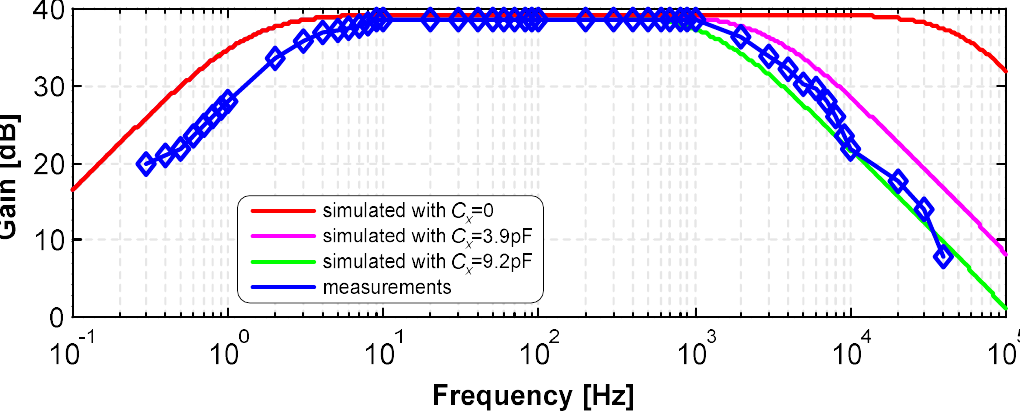
Figure 11. Measured gain and comparison with simulations for C x = 0, C x = 3.9 pF and C x = 9.2 pF. Notice that the upper cutoff frequency of the measured results is smaller than the ideally simulated value (pink plot in Figure 11, where C x =0 pF). It is caused by the